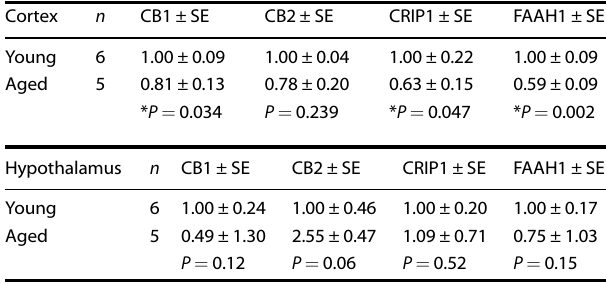
Table 1. Quantitative PCR analysis of gene expression in regions of brain tissue from young – adult (4 m) and old (22 m) male mice.